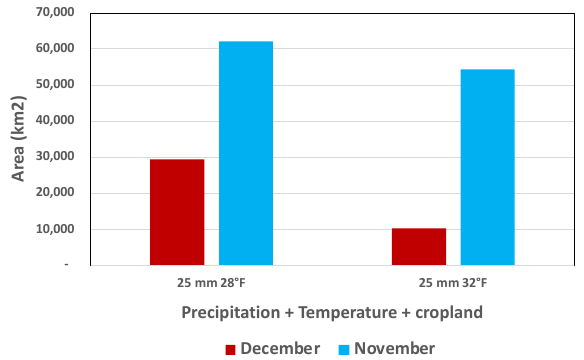
Figure 9. Comparison of all combinations in Figure 8a – d (note: 32 °F = 0 °C, 28 °F = −2 .2 °C). To obtain more specific information regarding the regions in southwest United States suitable for chia cultivation based on land use/land cover, precipitation, and temperature, the results shown in Figure 9 are presented at county levels for each of the states of California, Arizona, and Nevada (Figure 10). These represent active farming areas that do not have the extreme cold temperatures in the winter that would limit chia